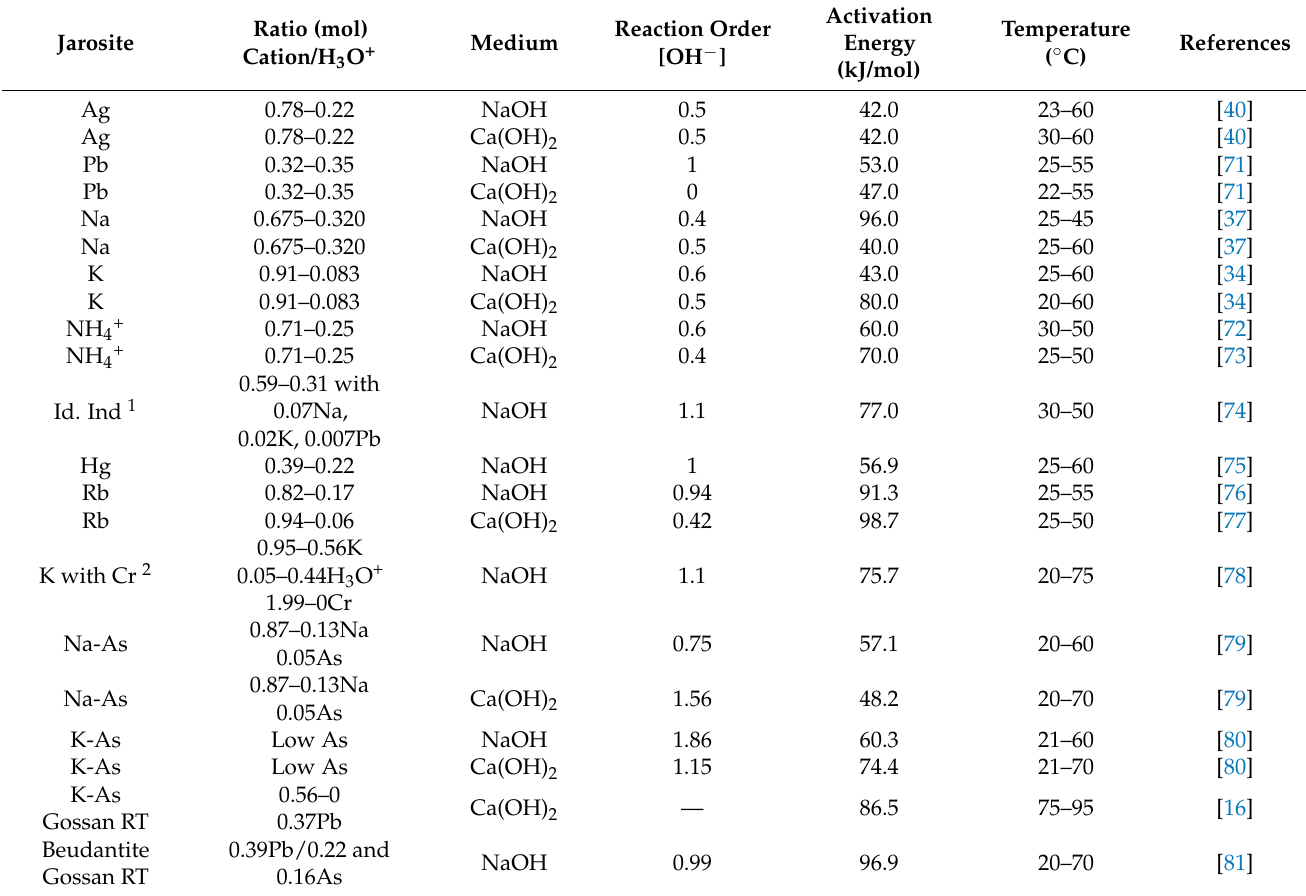
Table 5. Kinetic parameters of alkaline decomposition of some